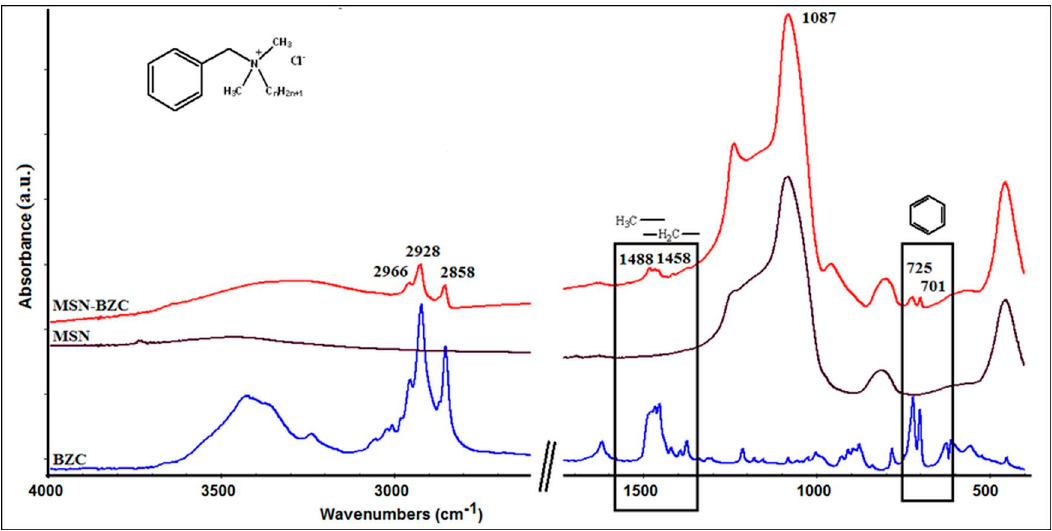
Figure 1. The Fourier transform ‐ infrared (FT ‐ IR) spectra for mesoporous silica nanoparticles (MSN), benzalkonium chloride (BZC) and MSN modified with BZC.